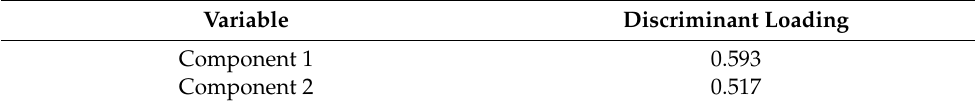
Table 7. Discriminant loadings of the two principal components.